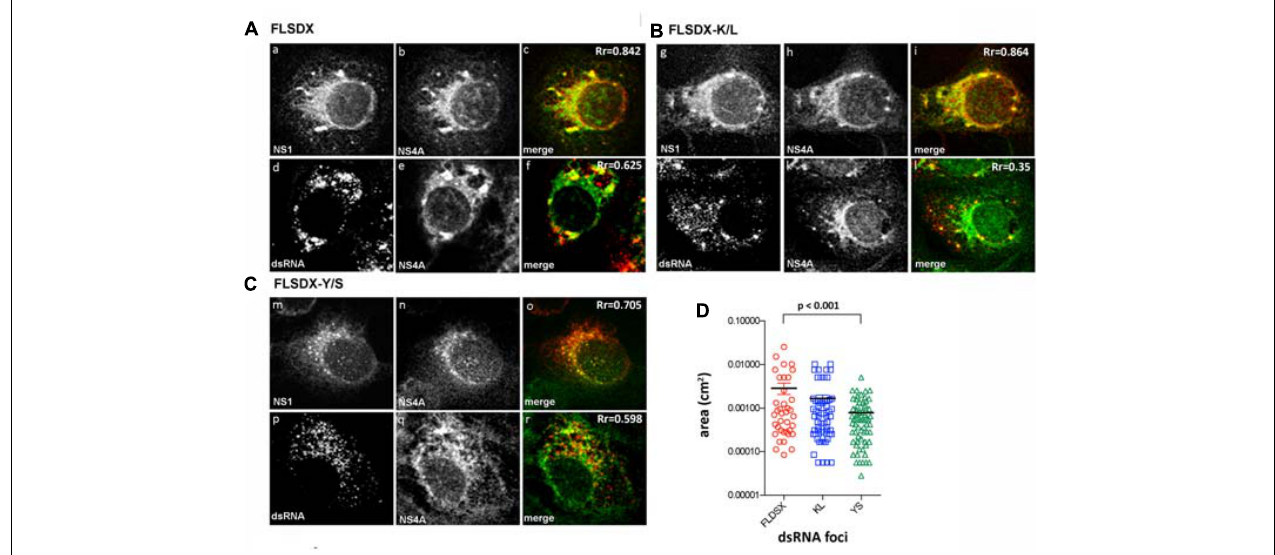
FIGURE 3 | Mutation within the CRAC motif prevents WNV KUN RC formation. Vero cells were transfected with FLSDX WT (A) , FLSDX K/L (B) , or FLSDX Y/S (C) RNAs and at 48 h.p.e. fixed for IF analysis. Transfected cells were then immune-stained with antibodies specific for WNV NS1 (in red) and NS4A (in green) or dsRNA (in red) and NS4A (in green). Images were collected on a confocal microscope; and yellow in the merge images indicates co-localization. (D) the size (area) of the dsRNA foci were analyzed by Image J software and statistical significance was determine by Student’s t-